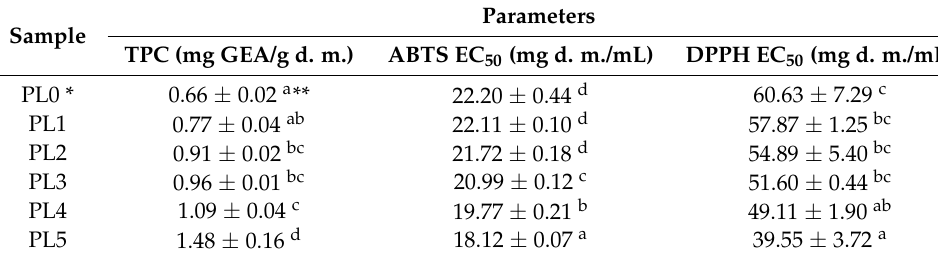
Table 4. Total phenolic content (TPC) and antioxidant activity (AA) of cooked pasta. Sample